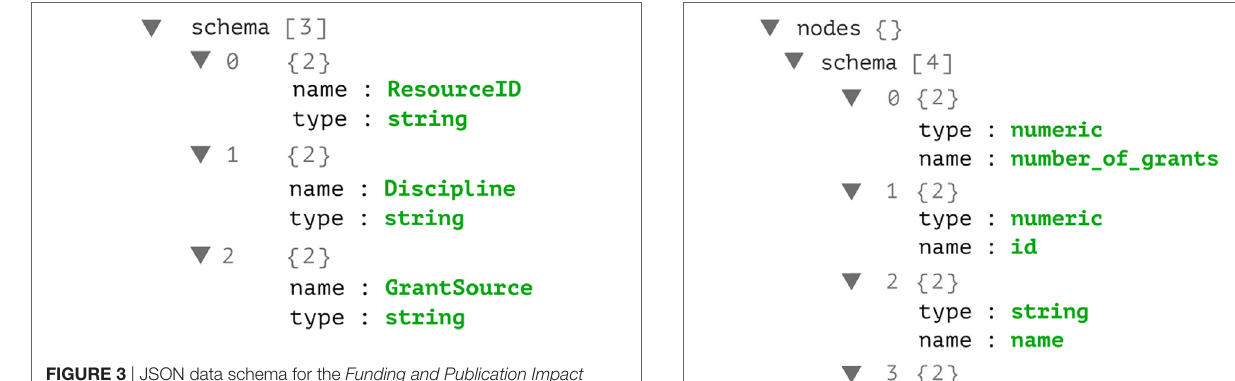
FigUre 3 | JSON data schema for the Funding and Publication Impact visualization